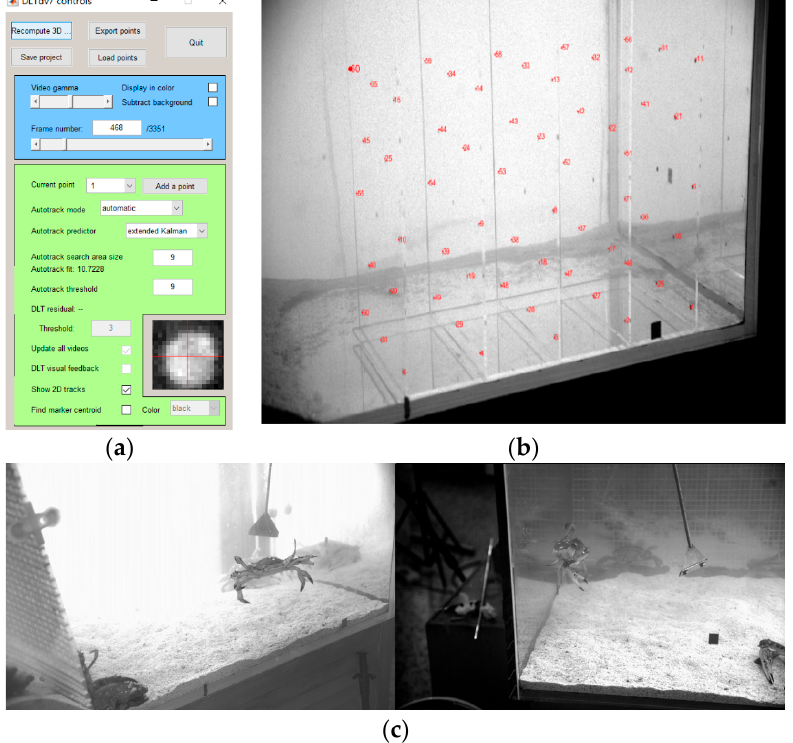
Figure 3. Direct linear transformation for crab kinematics. ( a ) is the software. ( b ) is the custom-made 60-point calibration object using an acrylic frame. ( c ) is the 2-D videos for crab kinematics.